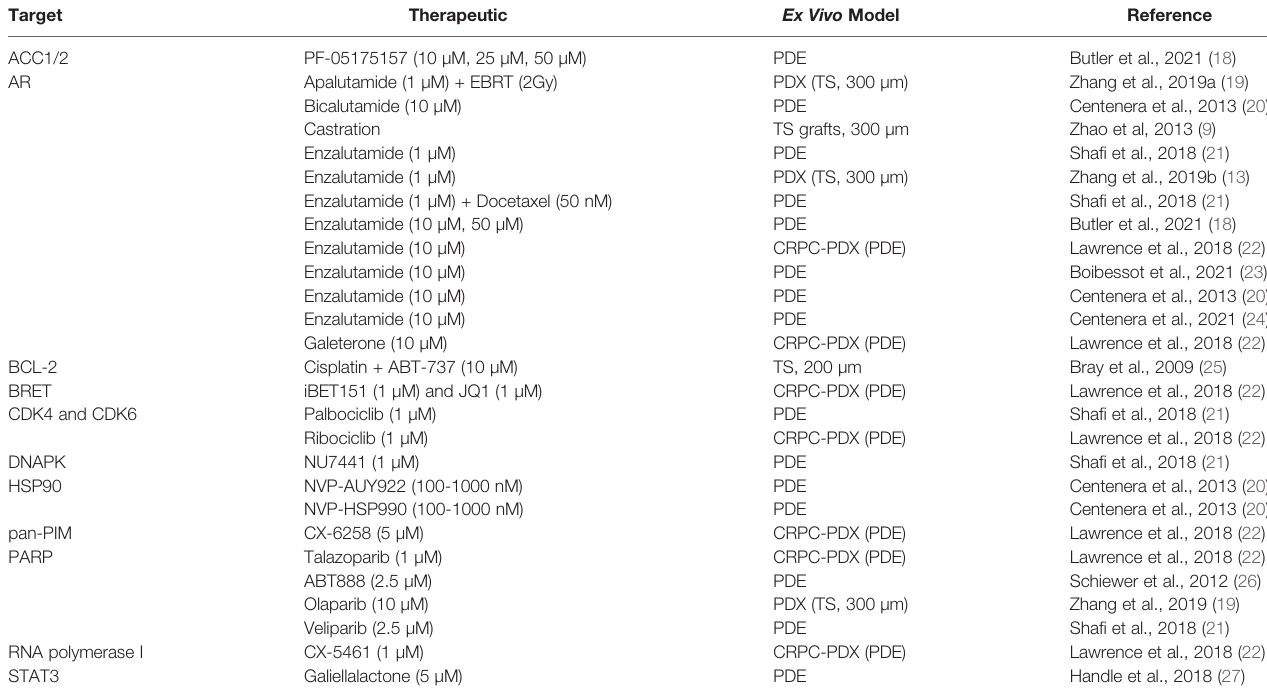
TABLE 1 | Therapeutics tested in ex vivo prostate